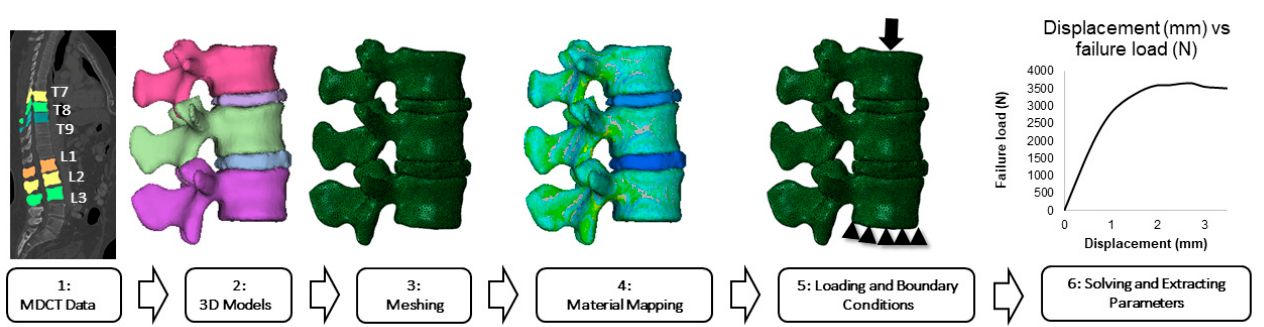
Figure 1. Overview of the analysis methodology for finite element models (FEMs). This figure provides an overview of the six-step analysis approach for the generation of FEMs, starting with extraction of multi-detector computed tomography (MDCT) datasets and resulting in solving and extracting parameters.